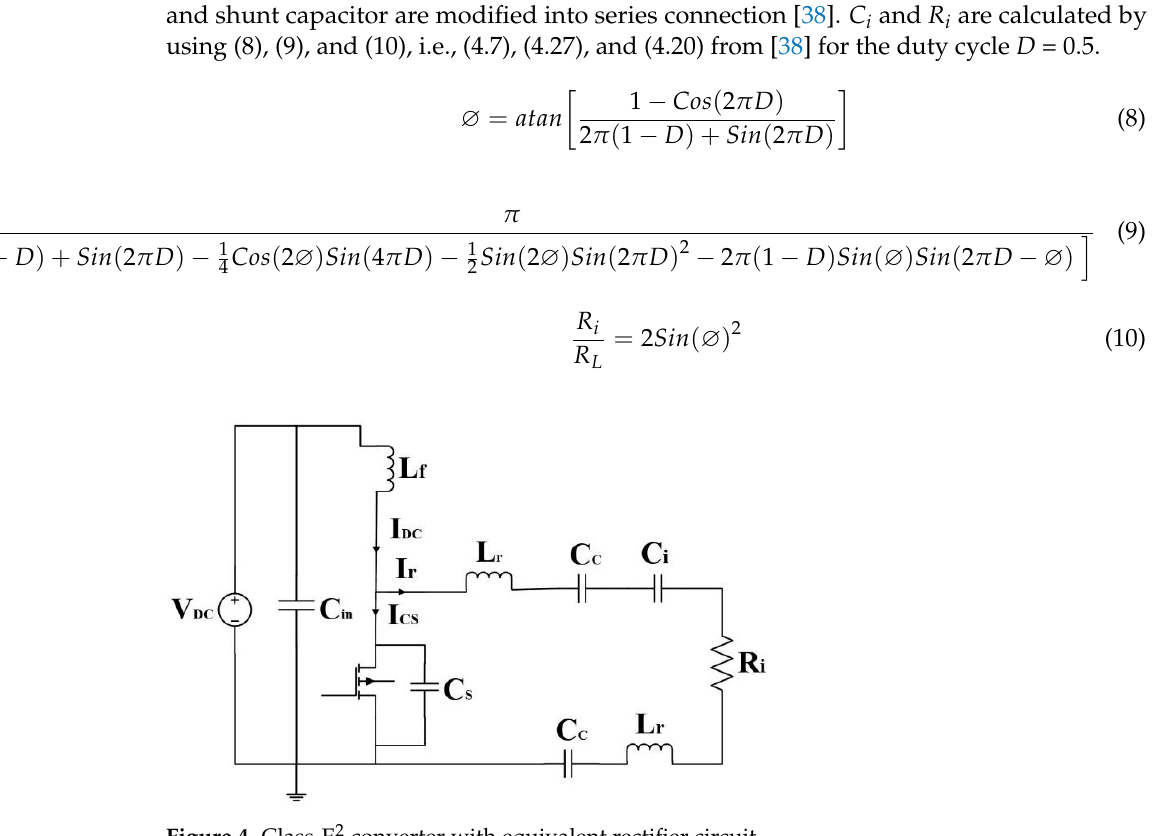
Figure 3. Circular capacitive-coupling plates manufactured for hardware tests in lab.